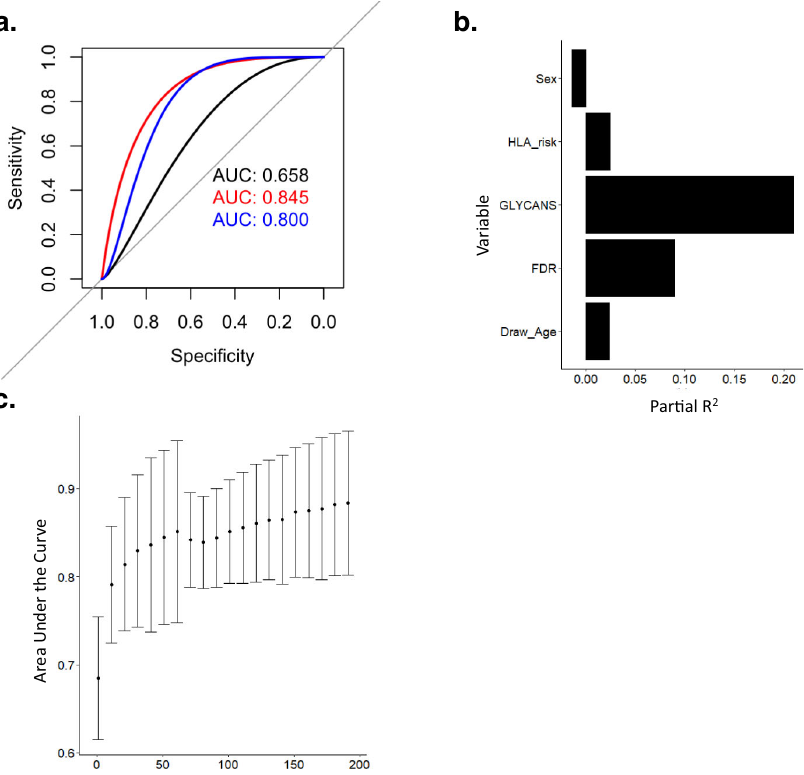
Fig. 5| ACAsimproveprediction ofT1D.a Receiver-operatorcharacteristic curve for three predictive models of T1D. A null model including sex, HLA risk, FDR, and draw age (black). A fullmodelincluding allvariables inthe nullmodel plus the fi rst principal component from each of the 11 clusters of ACA (red). A partial model including all variables in the null model plus the fi rst principal component from each of the 5 clusters of ACA signi fi cantly associated with progressors or non- progressors (blue). b The variance accounted for by each component of the full